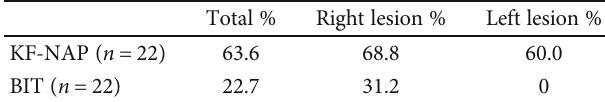
Table 5: USN detection rates measured in the KF-NAP group.